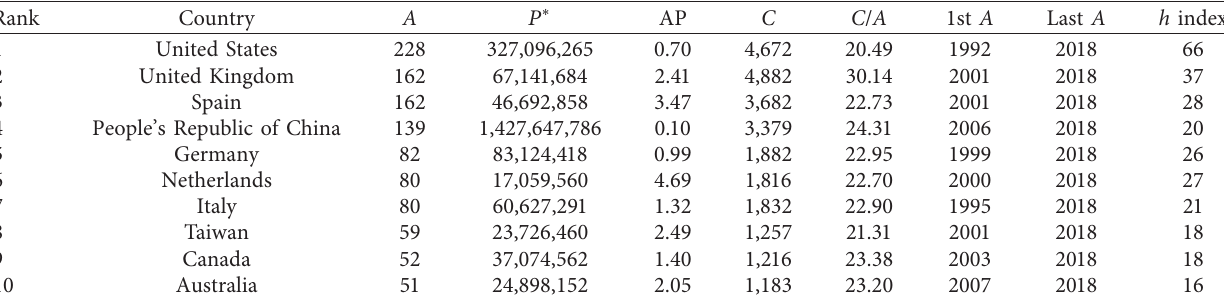
Table 8: Top ten most productive